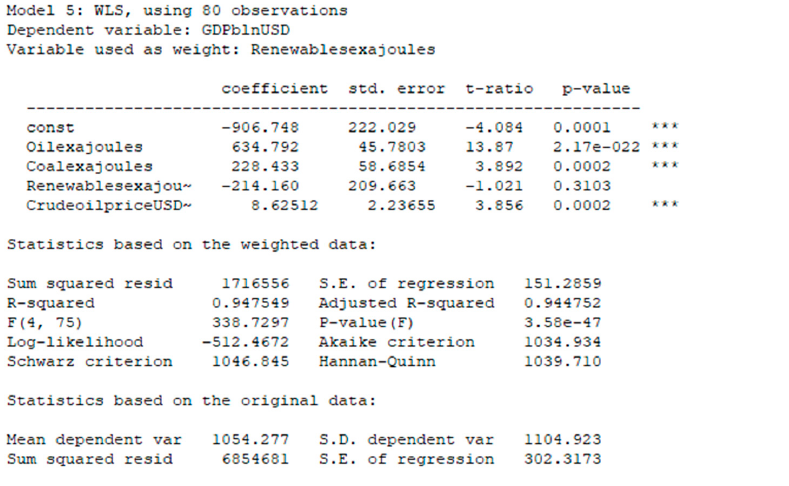
Figure 5. Testing Pooled regression models.